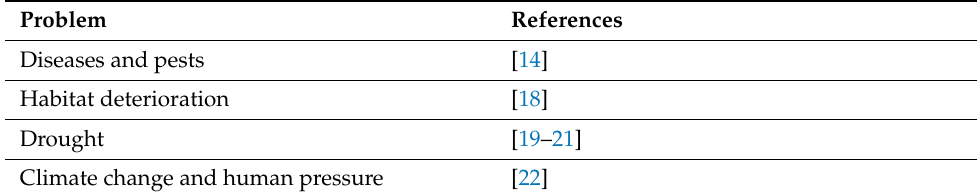
Table 1. Summary of the main ecological problems faced by